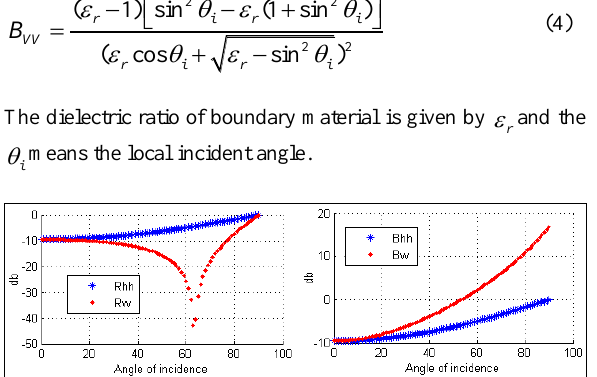
Figure 3. The theoretical intensity of the Fresnel and Bragg scatter in HH and VV channels. The ε r is given by 4.